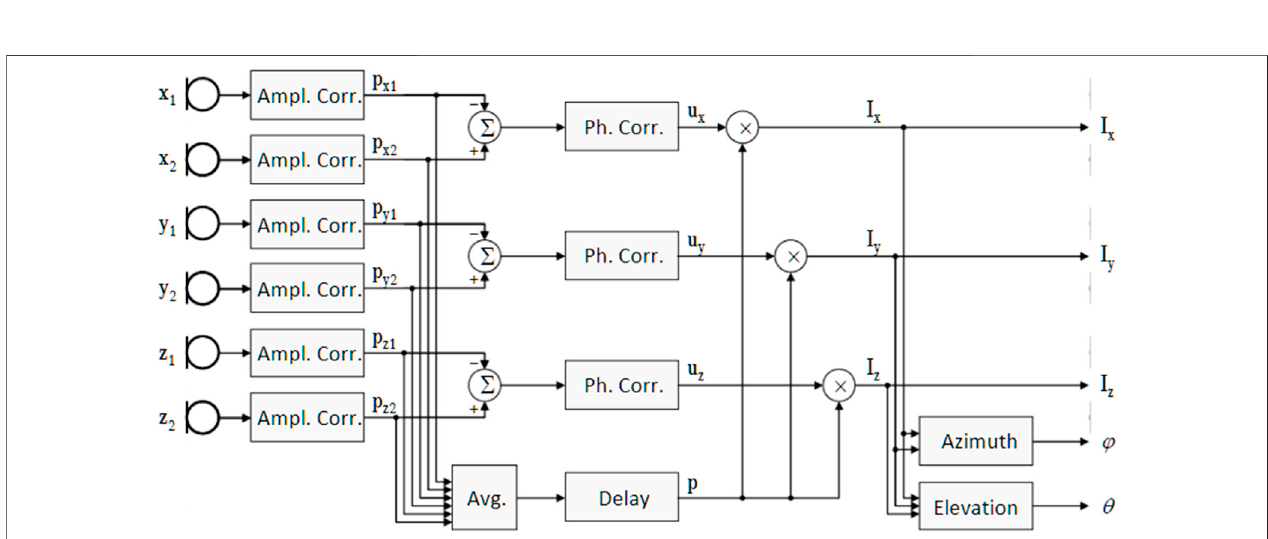
Frontiers in Energy Research |